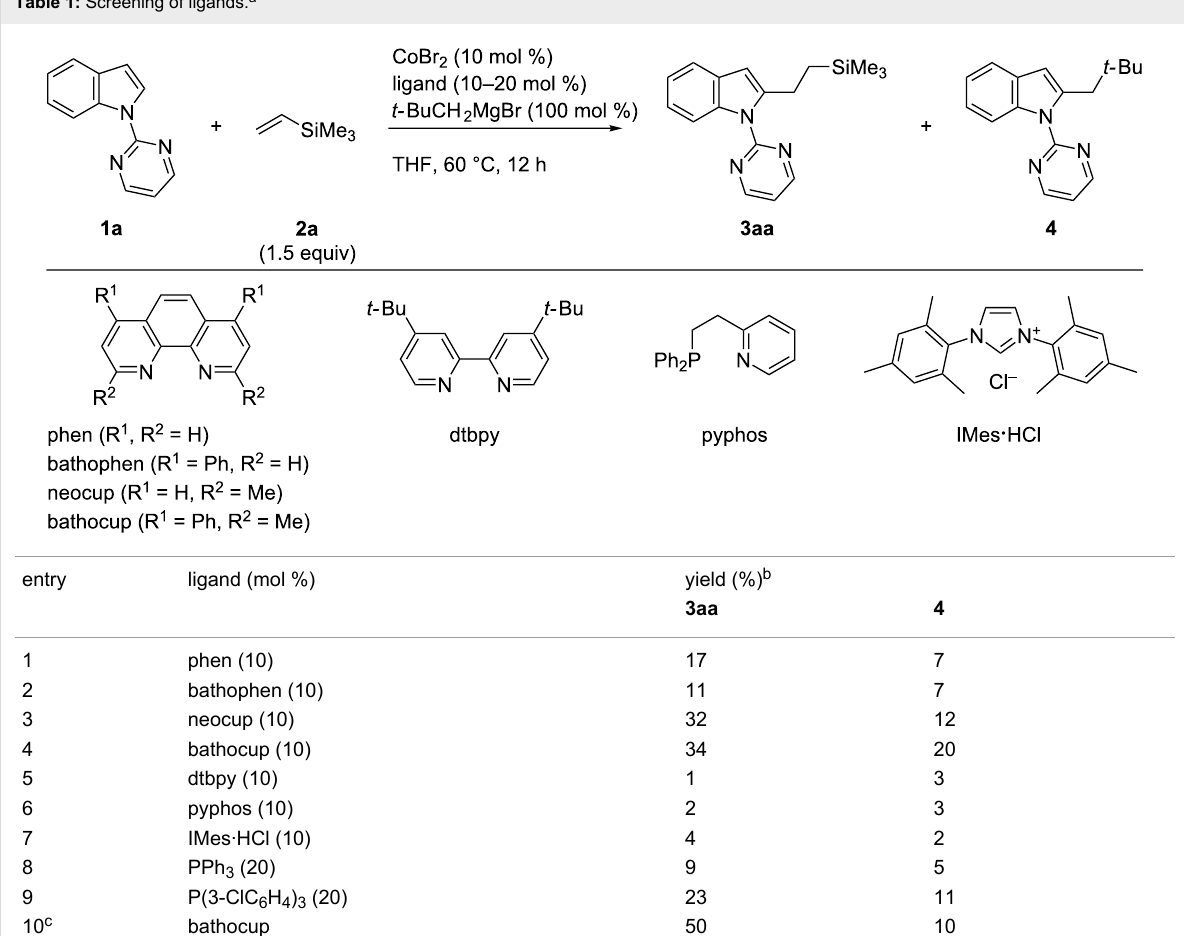
Table 1: Screening of ligands. a